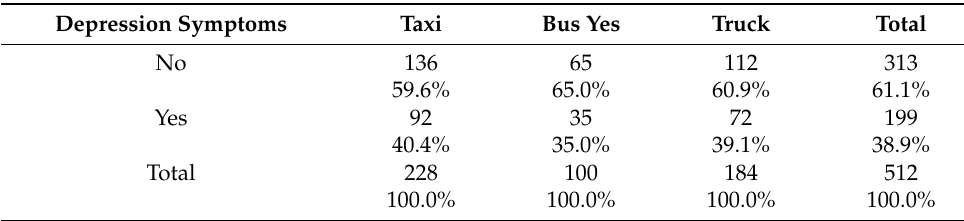
Table 2. Distribution of depression symptoms by driver type.